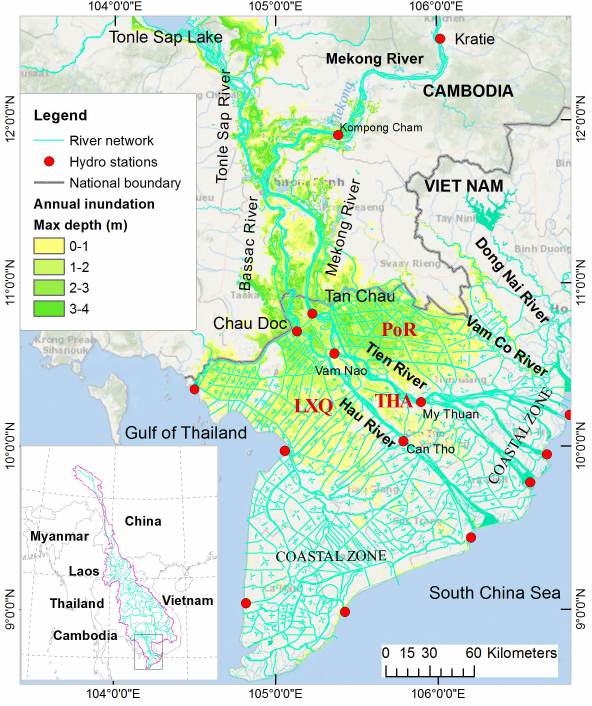
Figure 1. The Mekong Delta from Kratie to the coasts, including river network, main discharge stations and inundated area (average over 10